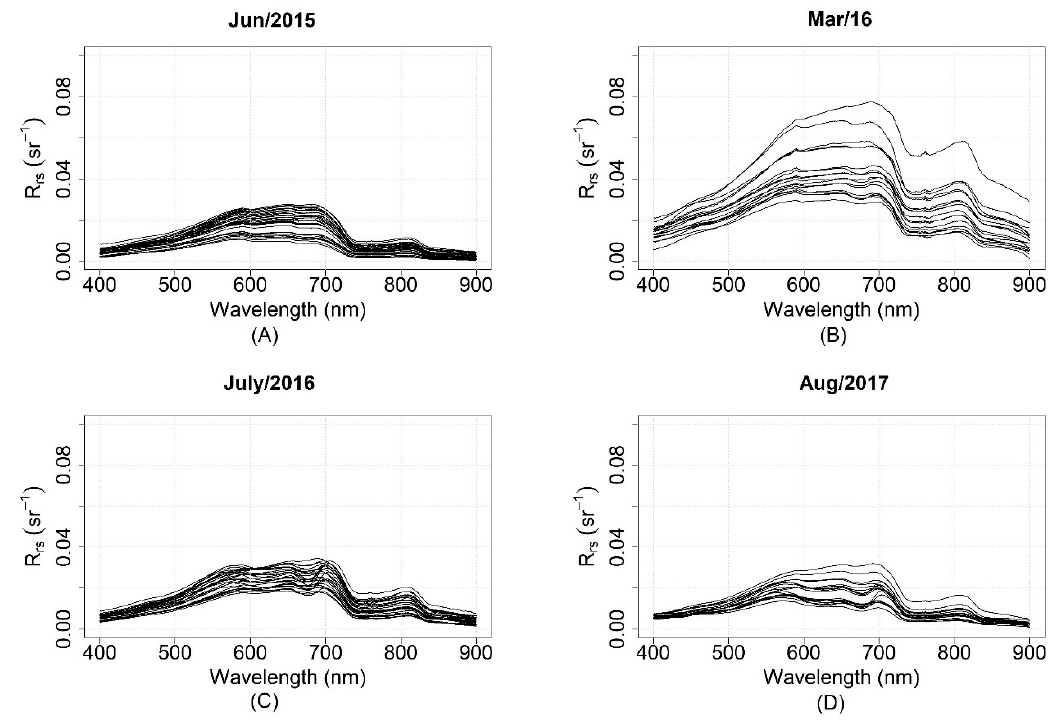
Figure 4. The R rs in situ spectrum separated by field campaign: ( A ) For June 2015; ( B ) for March 2016; ( C ) for July 2016; and ( D ) for August 2017.